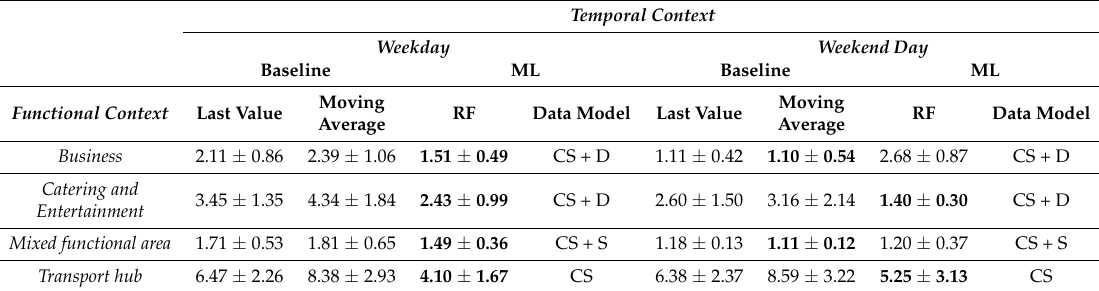
Table 1. Comparison between ML-based and baseline solutions in terms of MAE (avg ±